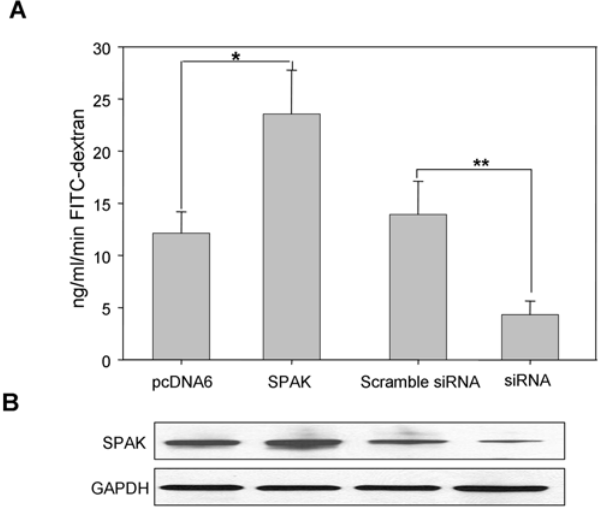
Figure 8. SPAK is involved in epithelial barrier function invitro . A. In vitro permeability assay in Caco2-BBE cells transfected with pcDNA6, SPAK/pcDNA6, con siRNA or SPAK siRNA with 4 kDa FITC- Dextran. Fluorescence was quantified in lower chamber at 2 hours after the administration of FITC-dextran ( l ex=492 nm, l em=510), *p , 0.05, **p , 0.01. B. Western blot of Caco2-BBE cells protein scraped from filter after the in vitro permeability assay.